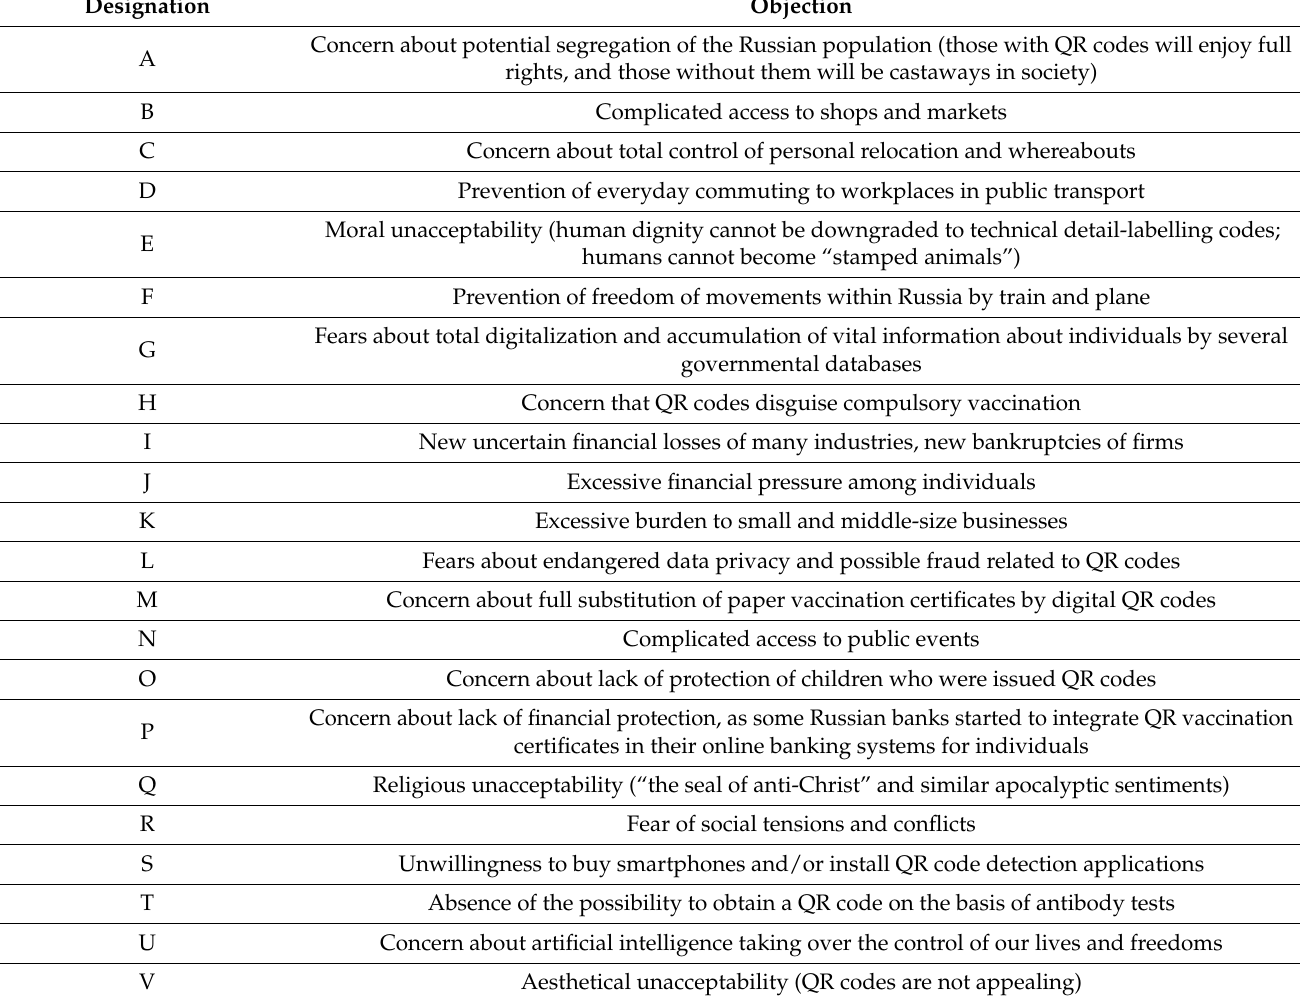
Table 2. The legend for Figure